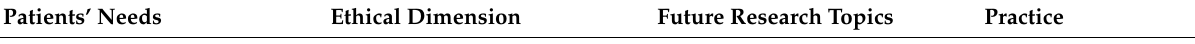
Table 6. Individual and organisational HL development at a